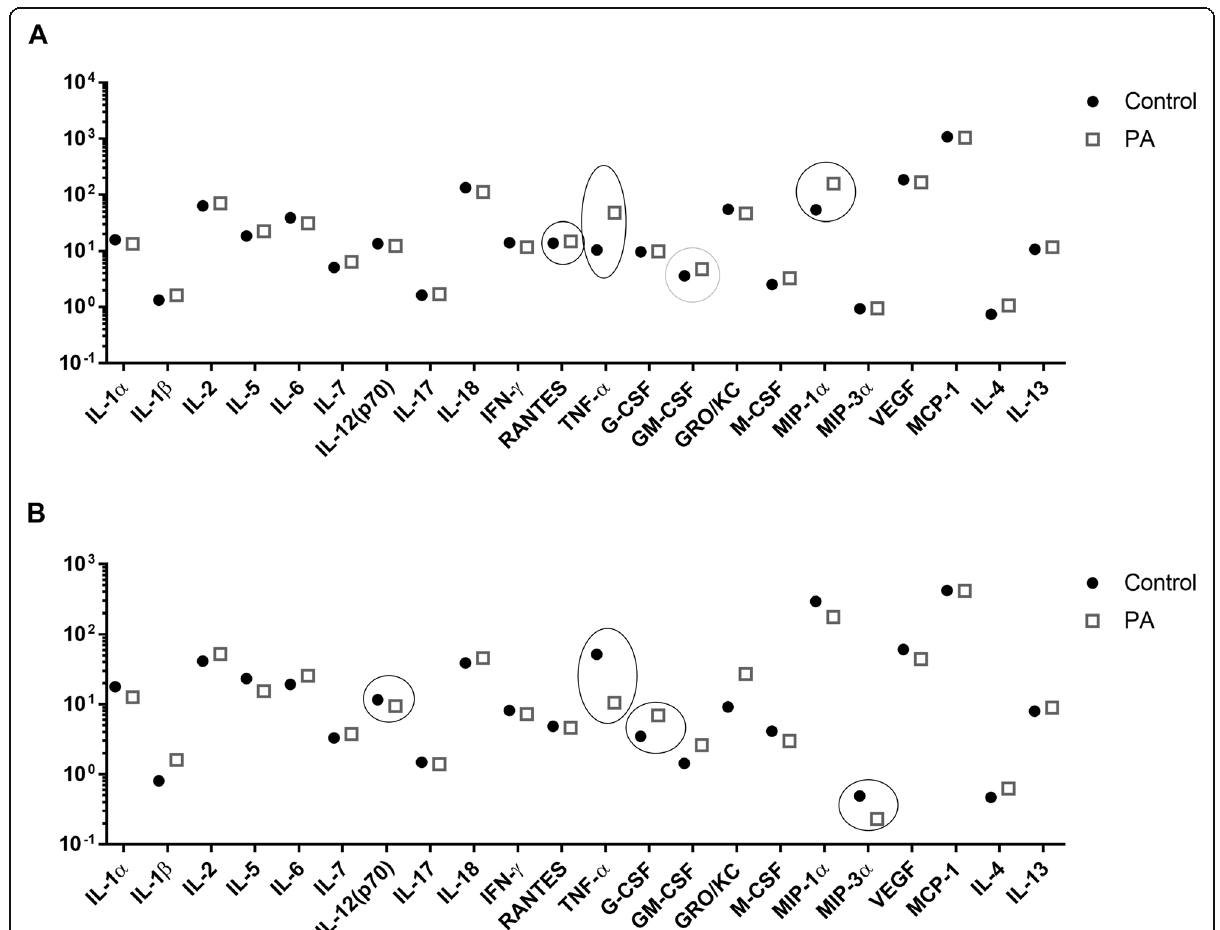
Fig. 5 Cytokine profile from subcutaneously implanted unfunctionalized (Control) and functionalized (PA) scaffolds ( A ) 4 days and ( B ) 4 weeks post-implantation. Data are presented on a logarithmic scale (Log 10). Statistically significant readings are highlighted by circles. Black circle p < 0.05, Grey circle p <